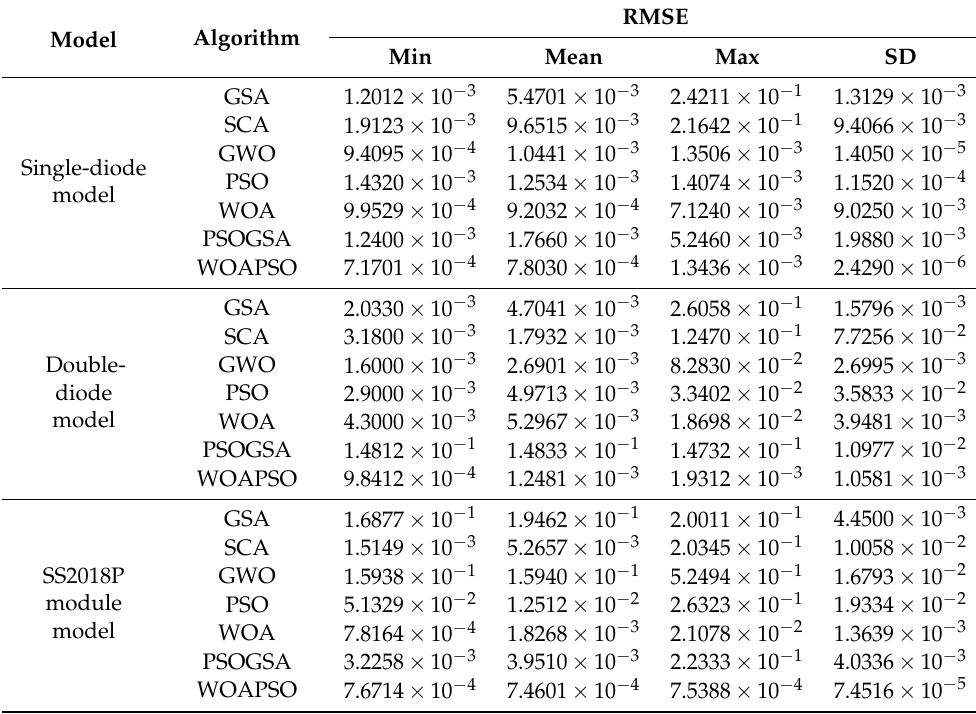
Table 5. Statistical results of RMSE of different algorithms for all three models.